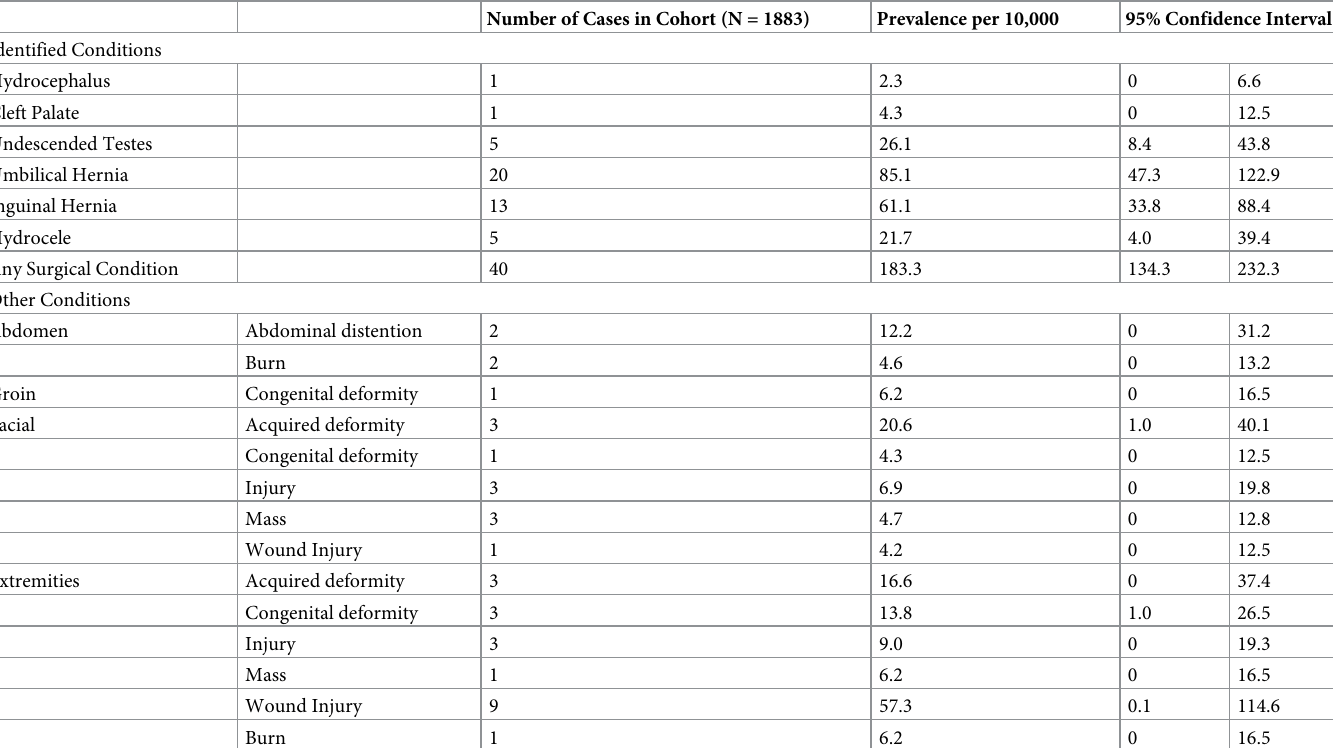
Table 1. Prevalence of pediatric surgical conditions per 10,000